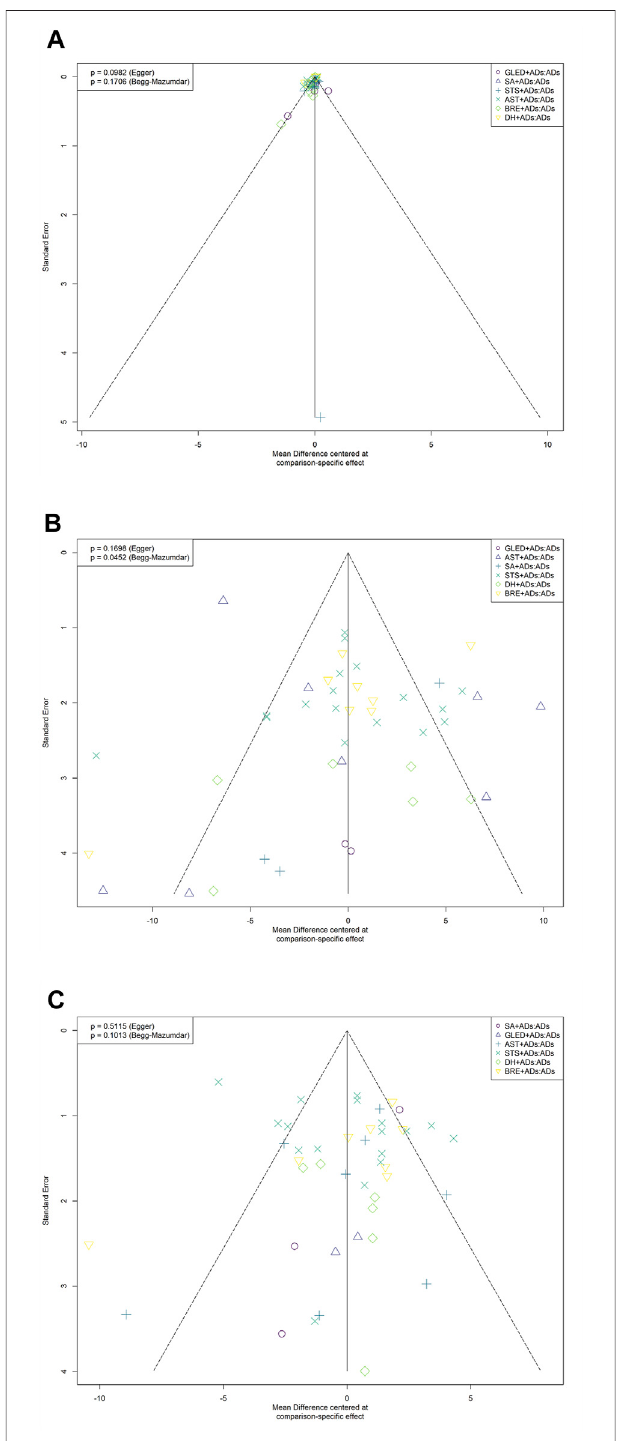
FIGURE 6 | Funnel plots for primary outcomes. ADs: antihypertensive drugs; SA: salvianolate; DH: danhong; BRE: breviscapine; AST: astragalus; STS: sodium tanshinone IIA sulfonate; GLED: ginkgo leaf extract and dipyridamole. (A) : 24-h urinary protein excretion; (B) : Systolic blood pressure; (C) : Diastolic blood